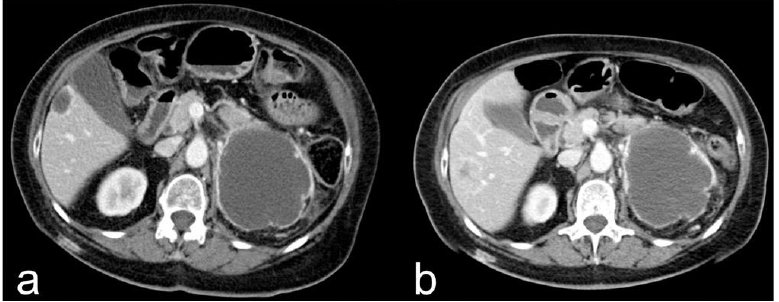
Figure 2. Contrast-enhanced CT axial scan during the venous phase of a 67-year-old female mRCC patient, showing a cystic renal cell carcinoma located at the upper pole of the left kidney ( a ). SD at follow-up with dimensional stability after ICI treatment ( b ).